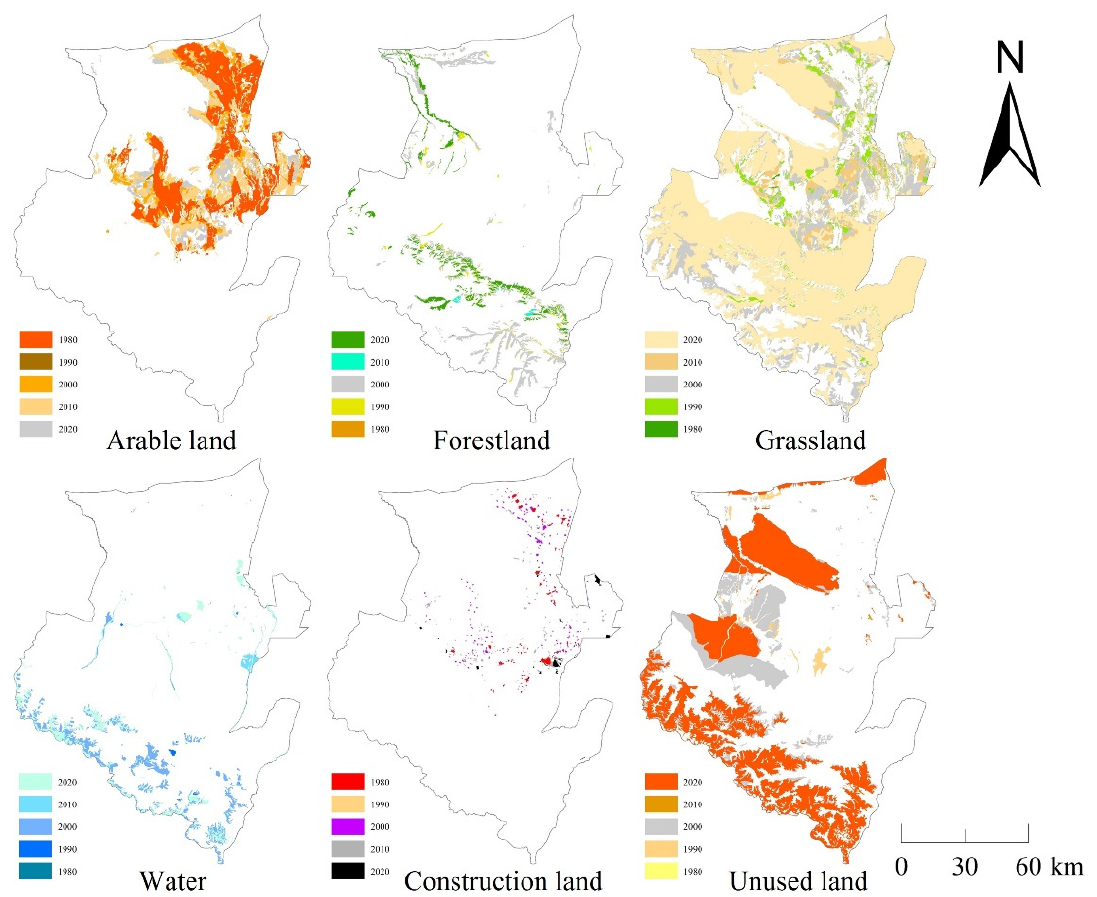
Figure 5. The change of land use areas from 1980 to 2020.